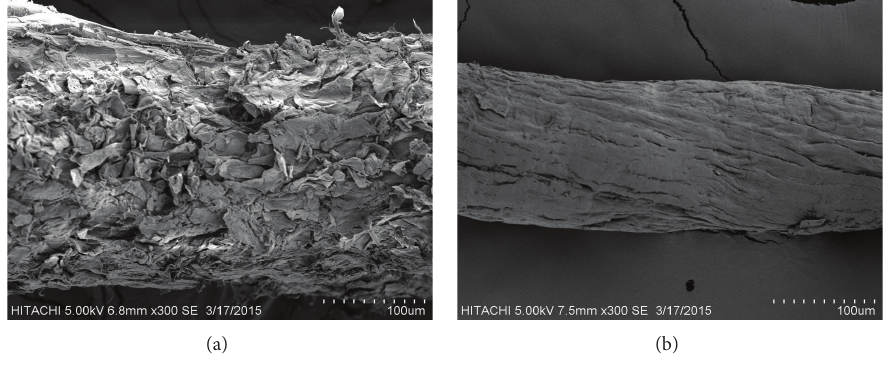
Figure 2: Scanning electron micrograph of (a) untreated durian peel and (b) cellulose.